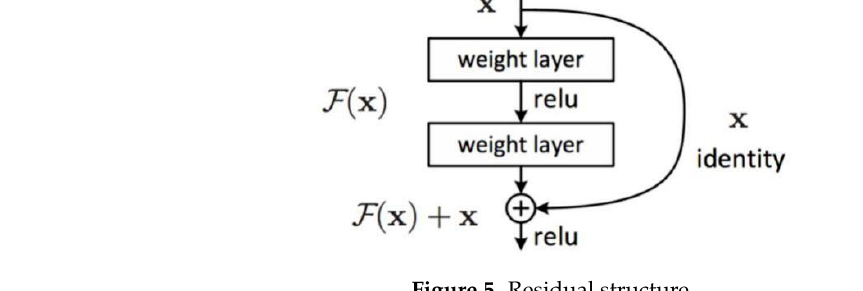
Figure 5. Residual structure.